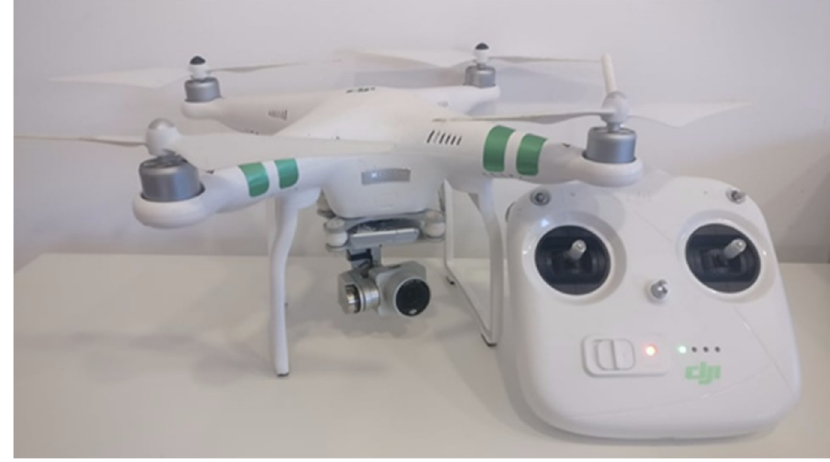
Figure 12. DJI Phantom 3 Standard.